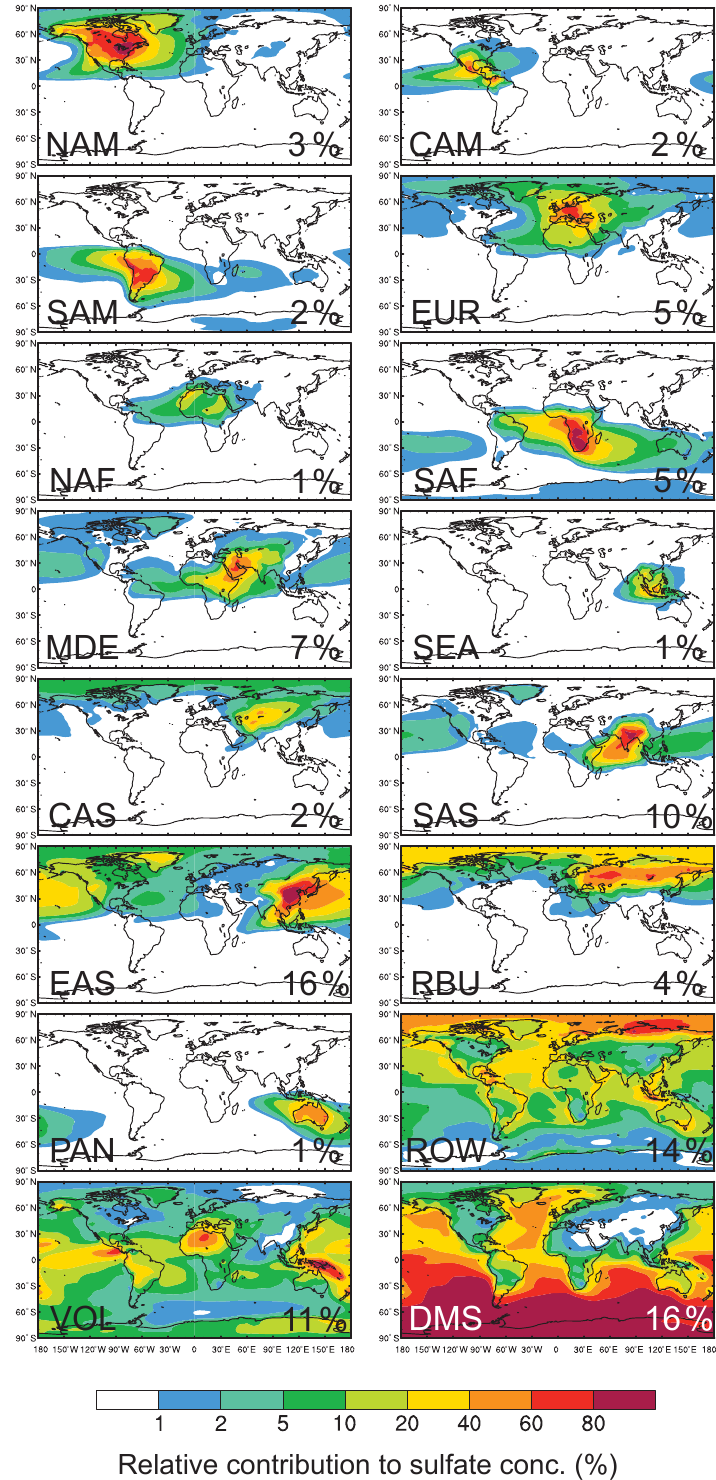
Figure 3. Spatial distribution of relative contributions (%) to annual mean near-surface sulfate concentrations from each of the tagged source regions/sectors. Relative contributions to global averaged sulfate from individual source regions/sectors is shown at the bottom right of each